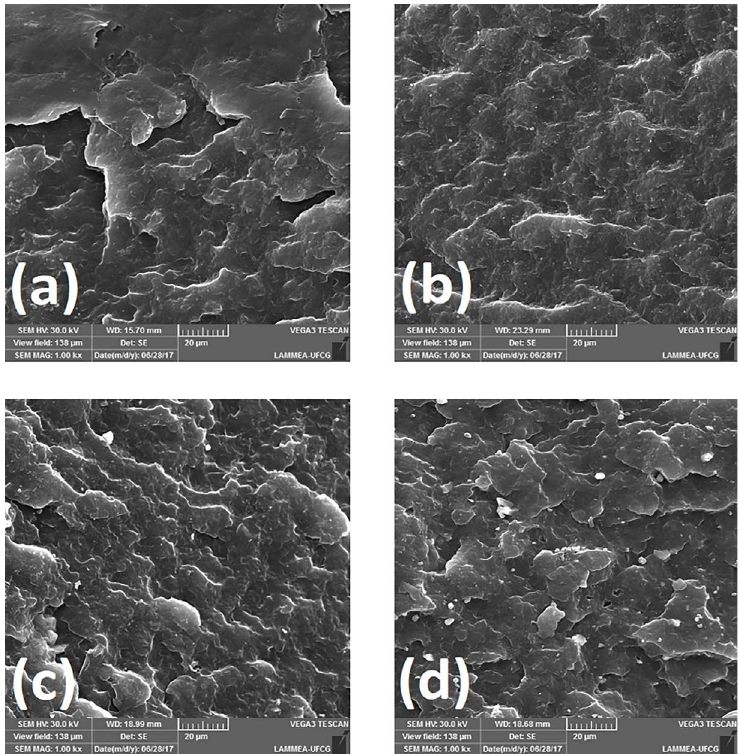
, (c) PP H103 + 30% R BB